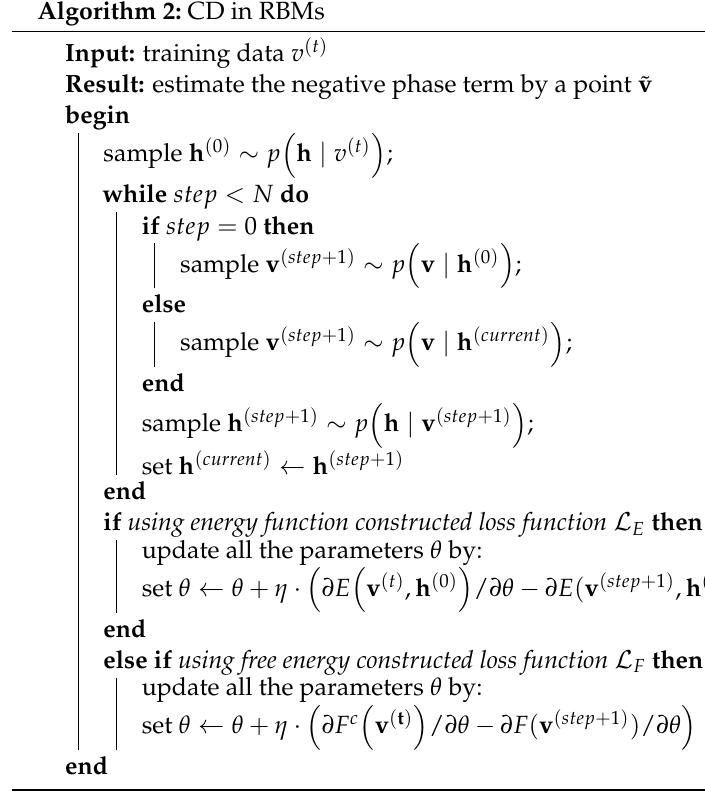
Algorithm 2: CD in